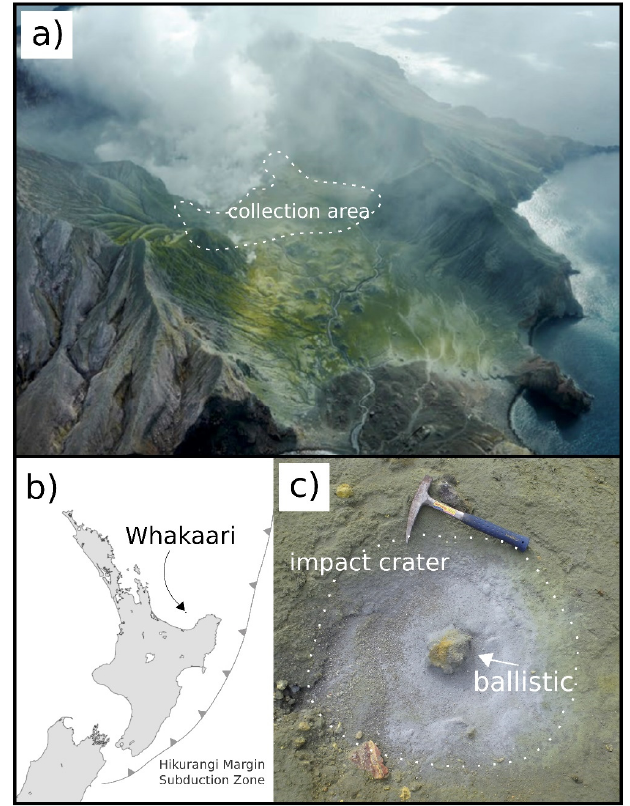
Figure 1. ( a ) Whakaari’s crater lake with ballistic collection area highlighted; ( b ) location of Whakaari north-east of the central North Island of New Zealand; ( c ) typical ballistic crater showing discoloration and partial burial of the ballistic.